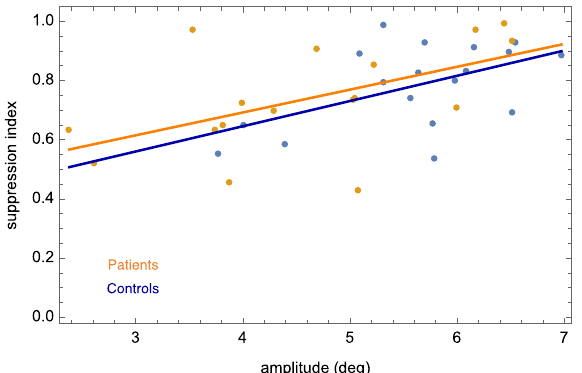
Figure 3. In both groups, smaller saccade amplitudes were related to a smaller suppression